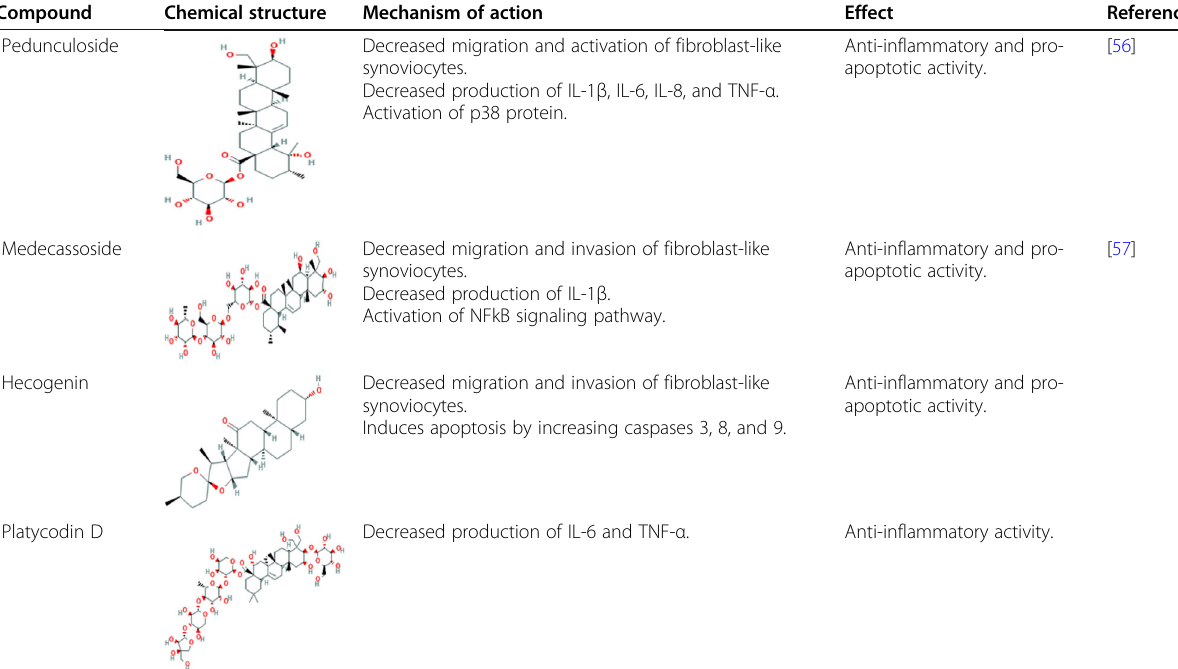
Table 2 Phytochemicals used in the treatment of rheumatoid arthritis